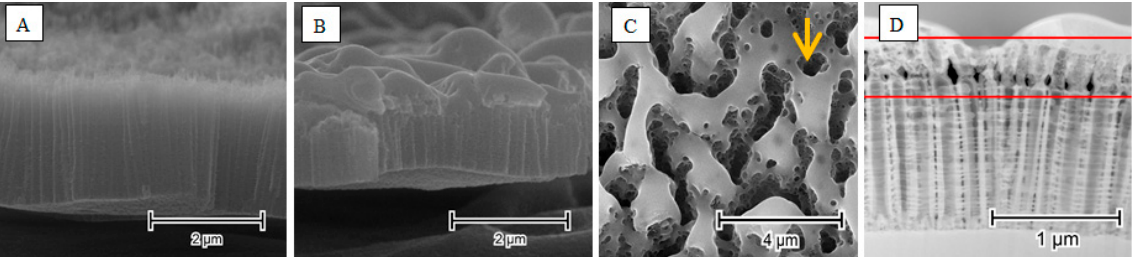
Figure 10. SEM images of as-anodized titania nanotubes ( A ), and nanotubes after laser-treatment ( B ). TEM images of hollow nanopillars from the top ( C ) and side ( D ). The arrow indicates the direction of laser beam. Reprinted with permission from [55].